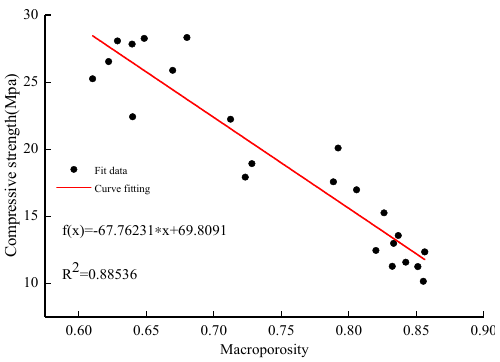
Figure 6. Fitting relationship between the propotion of macropores and compressive strength.